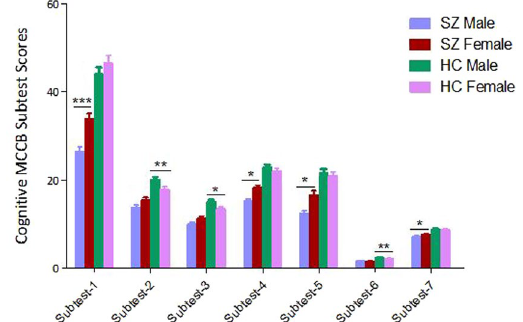
Figure 1. The cognitive test scores by MCCB in schizophrenia patients and healthy controls. Subtest-1: Symbol coding of processing speed; Subtest-2: Digital sequence of working memory; Subtest-3: Spatial span total of working memory; Subtest-4: Verbal learning; Subtest-5: Visual learning; Subtest-6: Reasoning and problem solving; Subtest-7: Social cognition. *** p < 0.001, ** p < 0.01 and * p < 0.05. SZ: Schizophrenia patients; HC: Healthy controls. MCCB: MATRICS (Measurement and Treatment Research to Improve Cognition in Schizophrenia) Cognitive Consensus